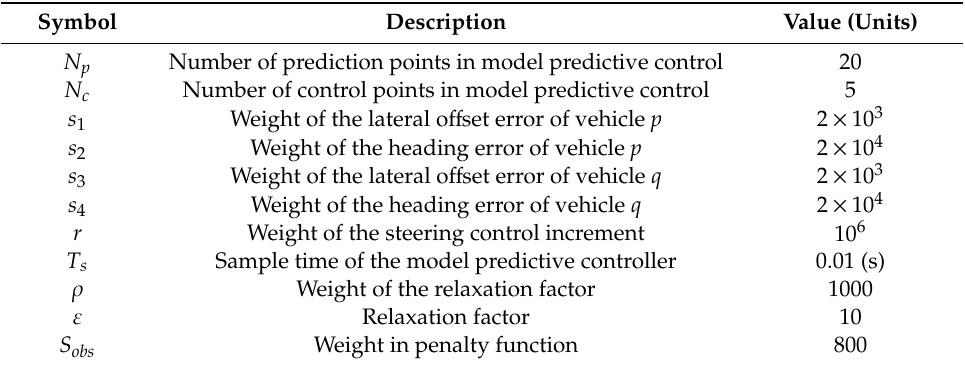
Table 3. The main parameters of MPC.